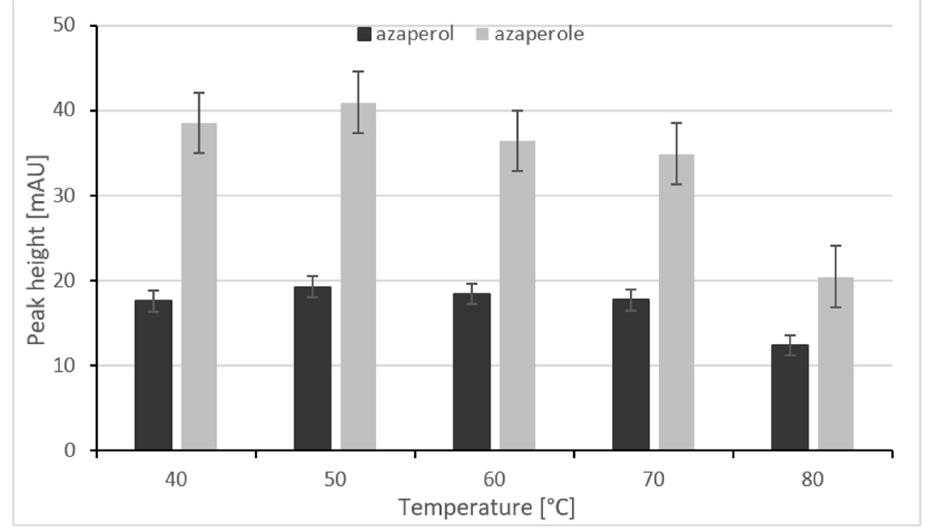
Figure 3. The relationship between the peak height and the temperature during